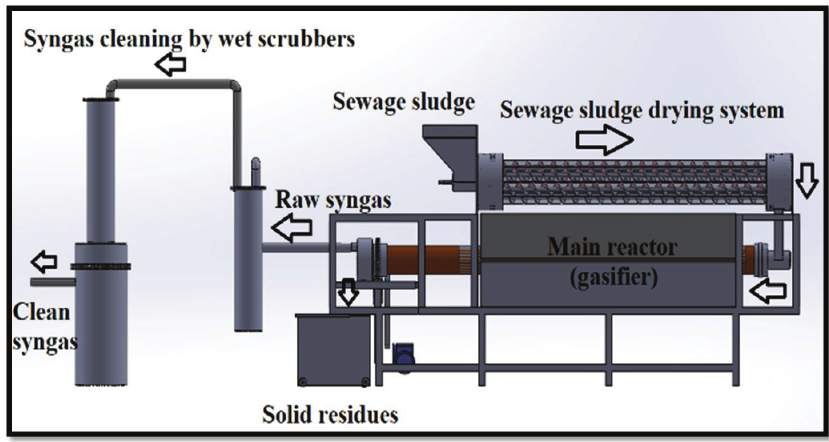
Fig. 1 – Gasification pilot